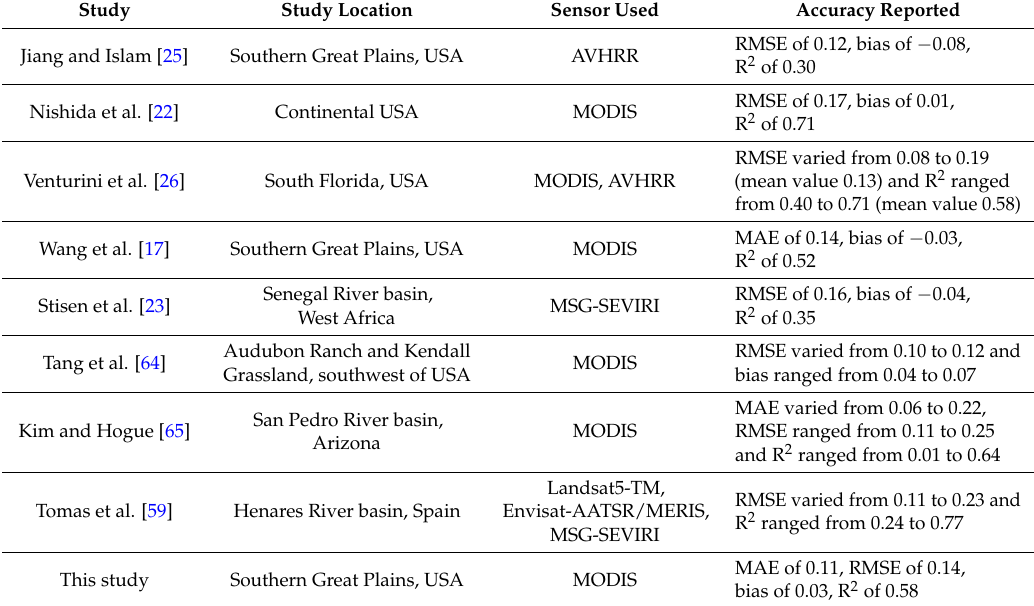
Table 5. Summary of relevant EF estimation studies based on the T s − VI triangle method. Study Study